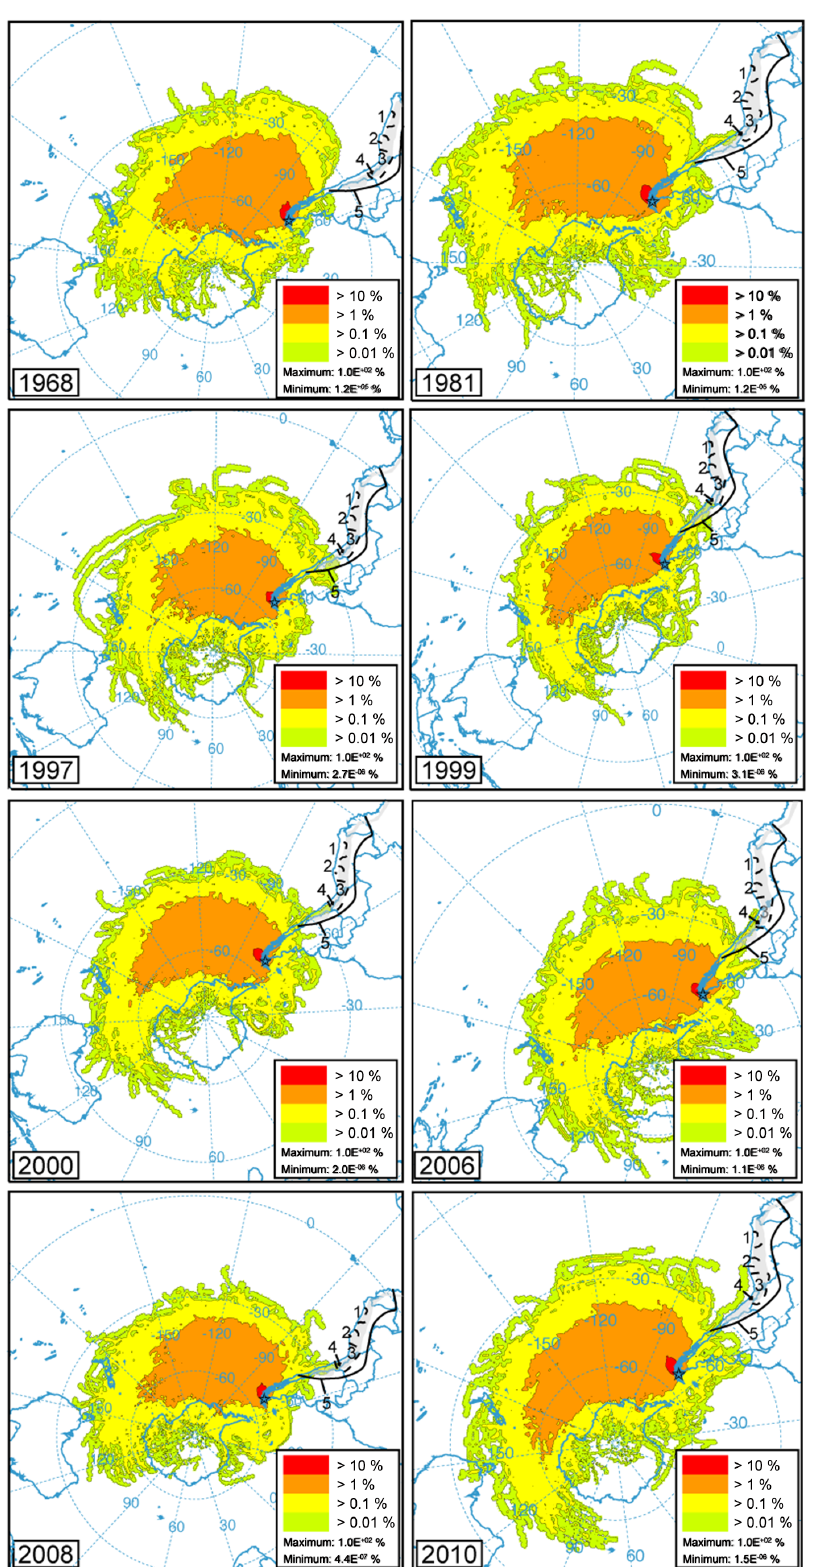
Figure 3. Back trajectory frequency corresponding to calendar years where air parcels are partially coming from NSA. The year 1968 is given as a comparison to show a year where no air back trajectory is coming from NSA (see figure S1 for all years from 1948 to 2012).